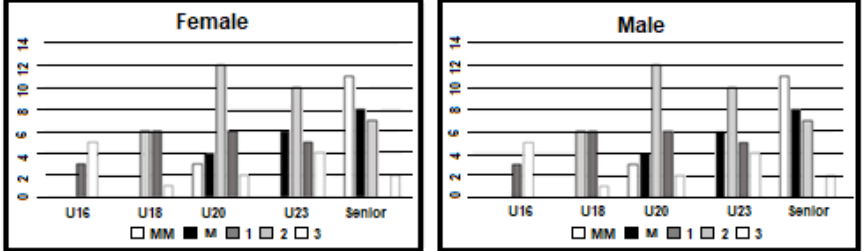
Figure 1. Quantitative characteristic of female and male athletes participating in the experiment, divided into sports classes (level of performance).